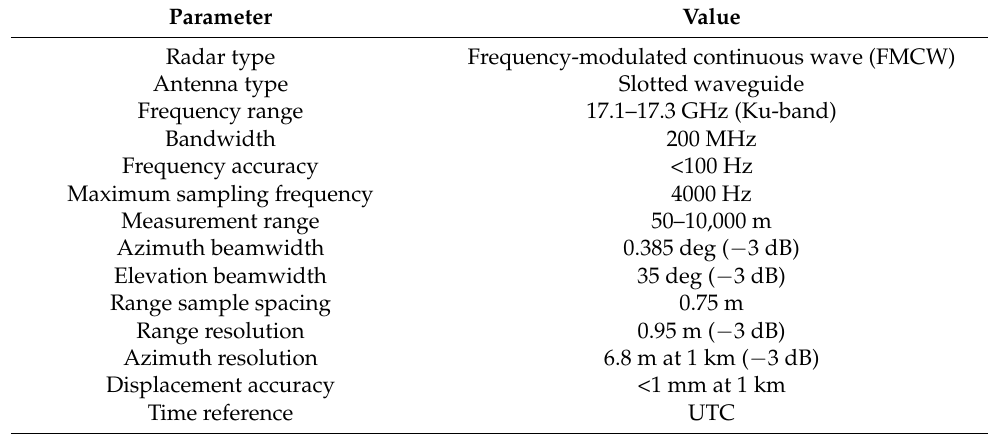
Table 2. The basic parameters of the GPRI-II.